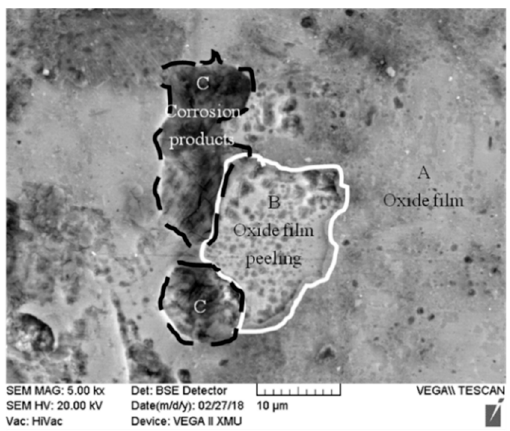
Figure 14. SEM morphology of Ti-6Al-4V titanium alloy after hot corrosion for 4 h.